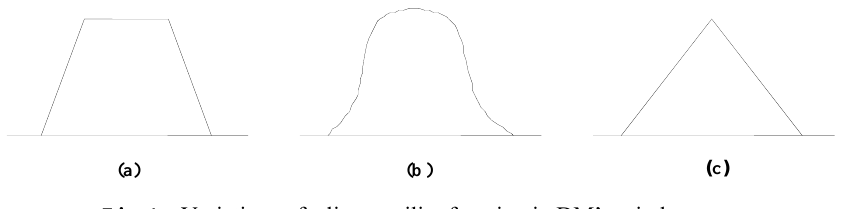
Fig. 4.a Variations of a linear utility function in DM’s mind Fig. 4.b Variations of a nonlinear utility function in DM’s mind Fig. 4.c Relational preferences resulted from variations of utility function in DM’s